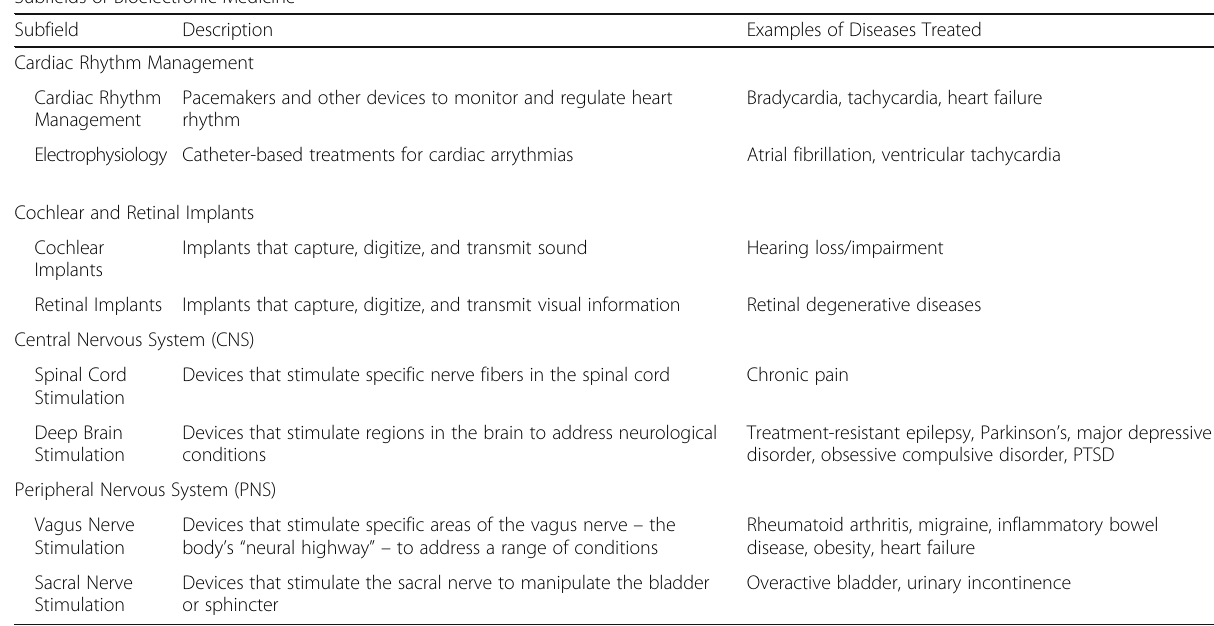
Table 1 Subfields of Bioelectronic Medicine